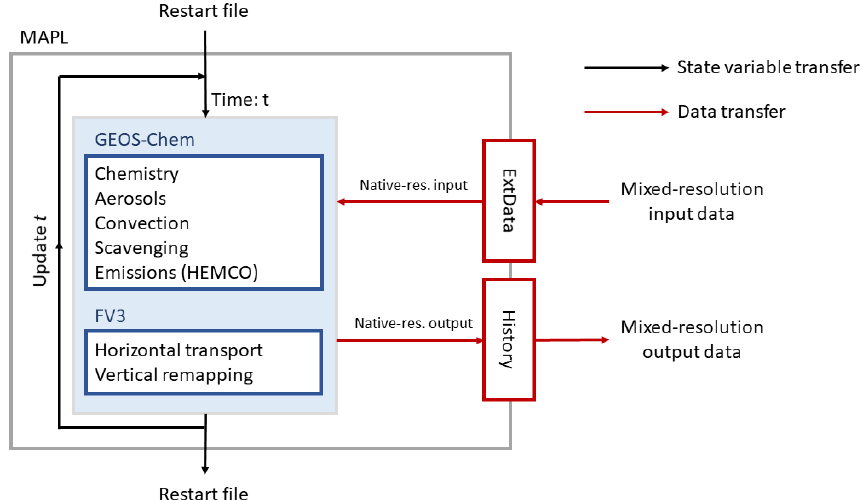
Figure 1. Connectivity of the major components of GCHP. The main time-stepping loop is represented by the feedback loop from the model output back into the